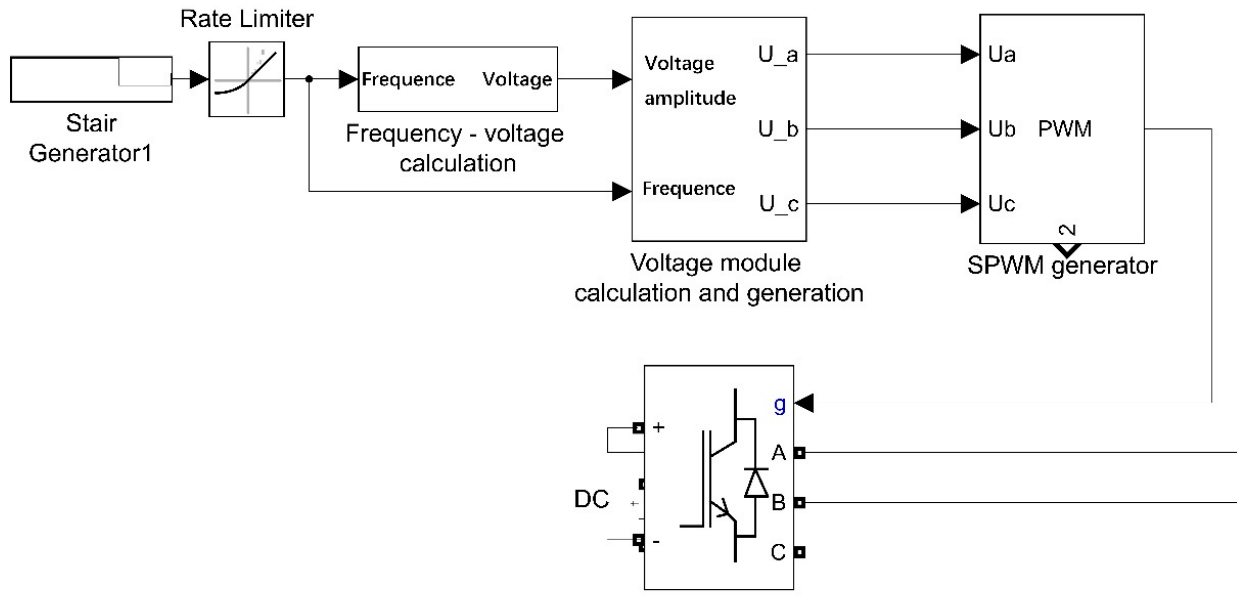
Figure 7. Simulink block diagram of inverter power supply.